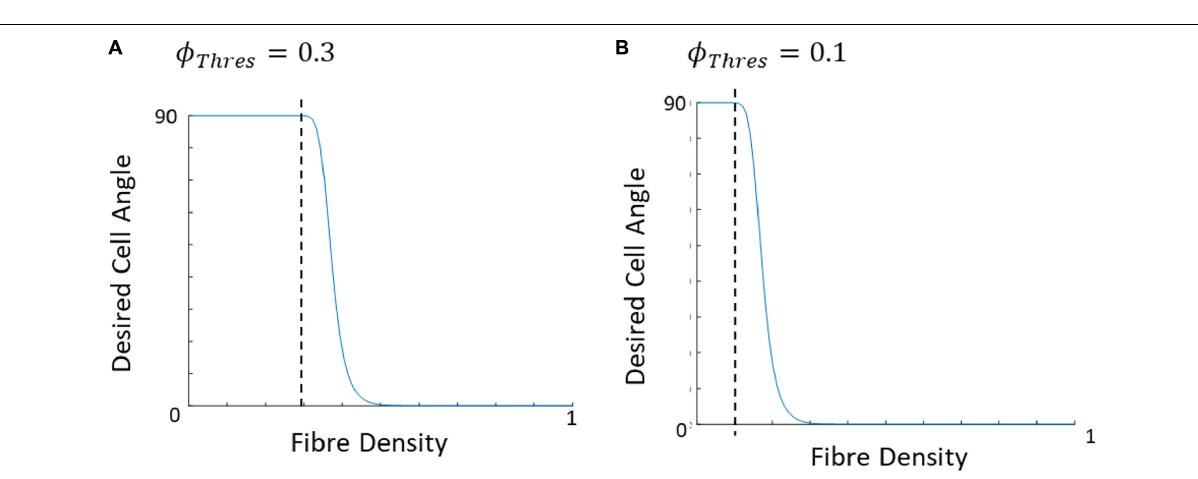
FIGURE 6 | Graphical representation of the influence of φ Thres on the desired cell angle, assuming both the strain and fiber direction are at 0 ◦ , when (A) φ Thres is 0.3 and (B) φ Thres is